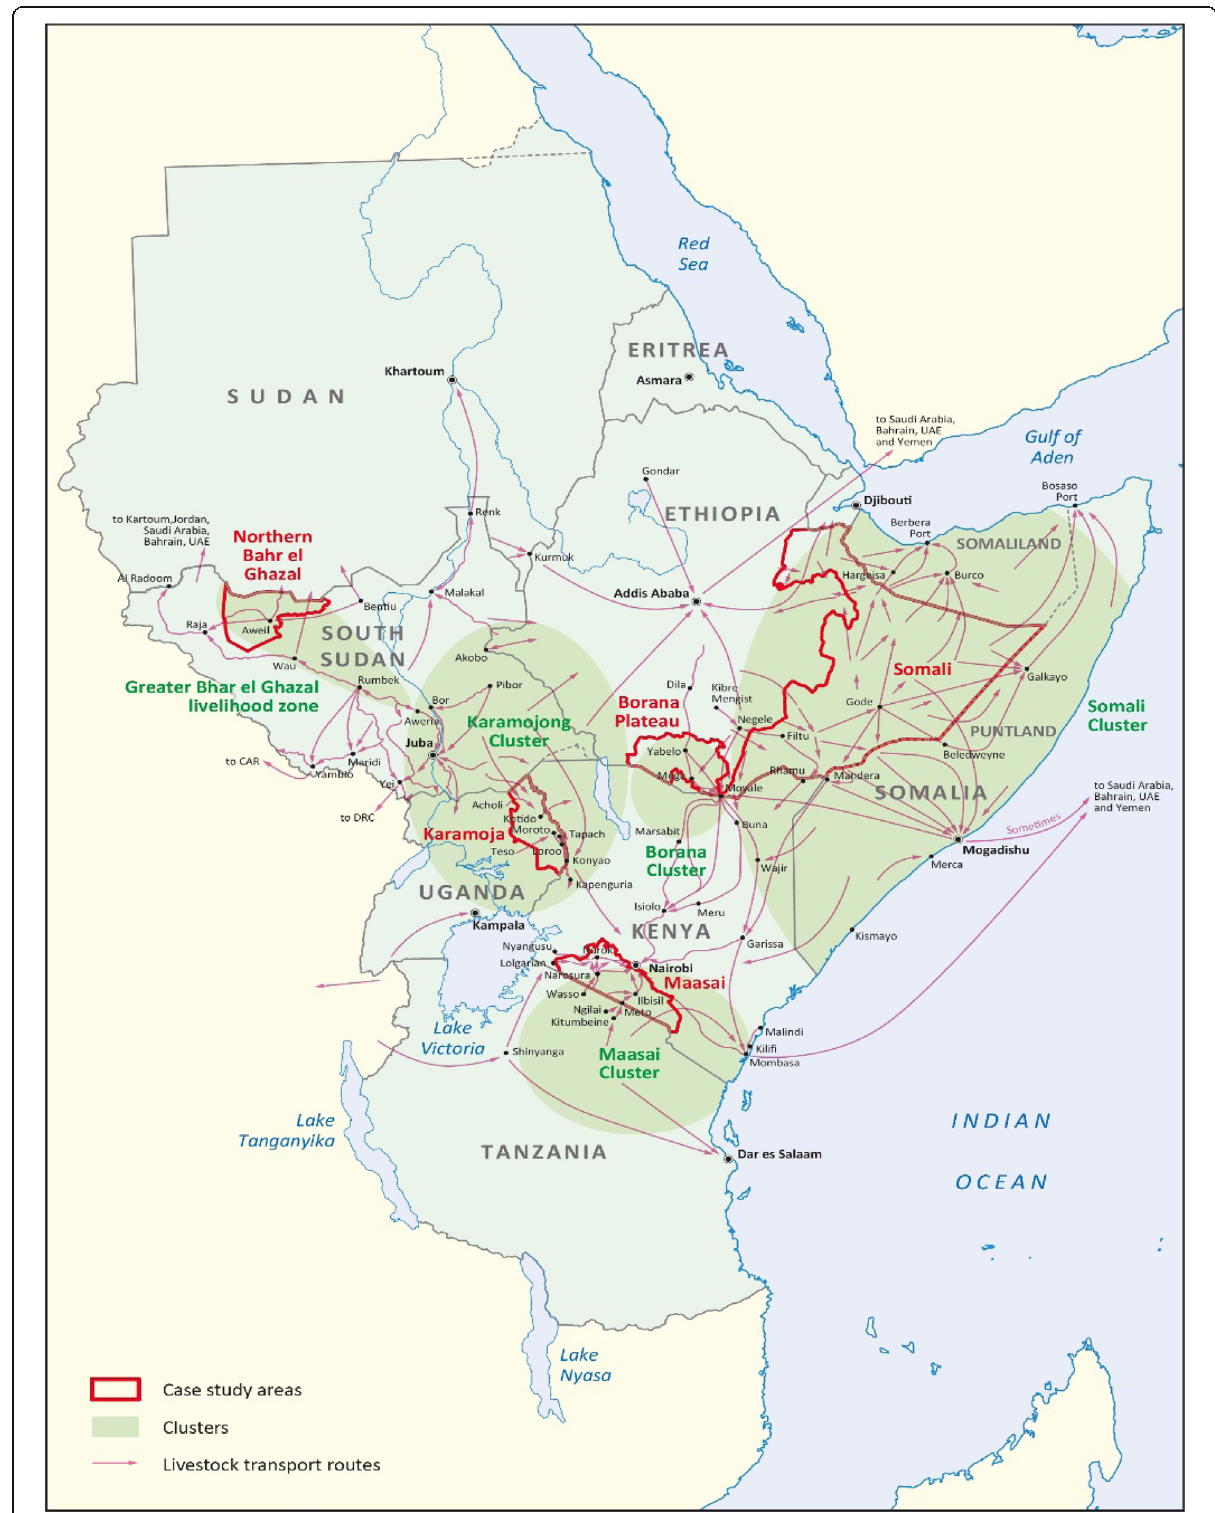
Fig. 1 Rangeland contexts in Eastern